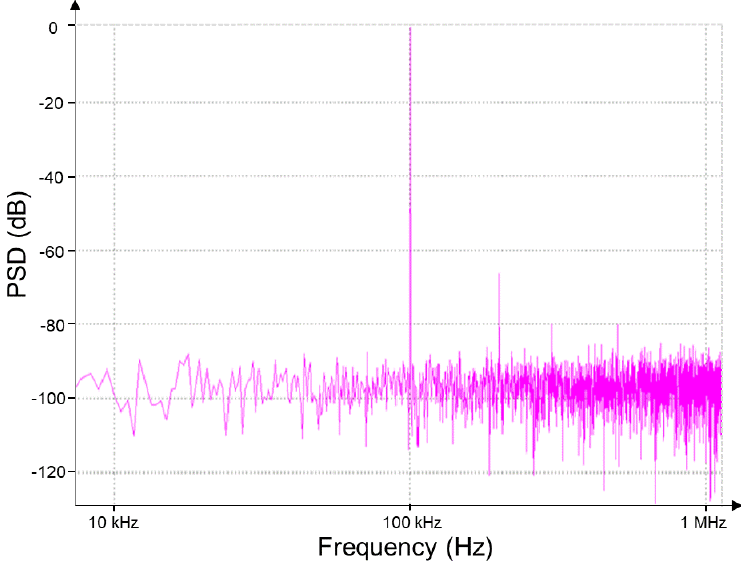
Figure 13. Post-layout-simulated PSD of the proposed SAR ADC. Table 4. Post-layout-simulated results of the proposed SAR ADC with three design corners.